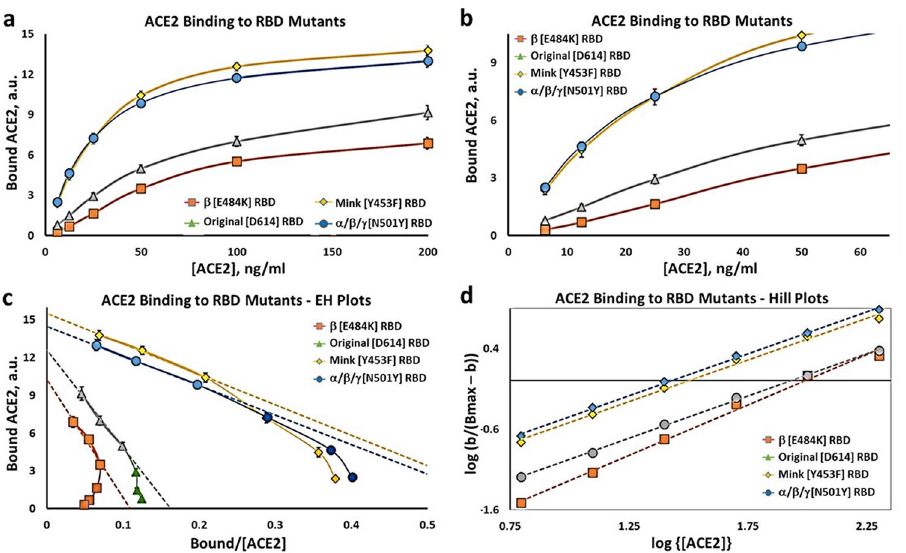
Figure 3. Binding kinetics for ACE2 to β [E484K], Mink [Y453F], α/β/γ [N501Y], and original [D614] RBDs. ( a ) Substrate-binding plots for ACE2 binding to RBD proteins. ( b ) Data from Part ( a ) at low concentrations of ACE2. ( c ) Eadie–Hoffstee plots for mutant RBD proteins compared to Original [D614] RBD. ( d ) Hill plots for mutant and Original [D614] RBD proteins. Each point is the average ± SE for N = 5–6 independent